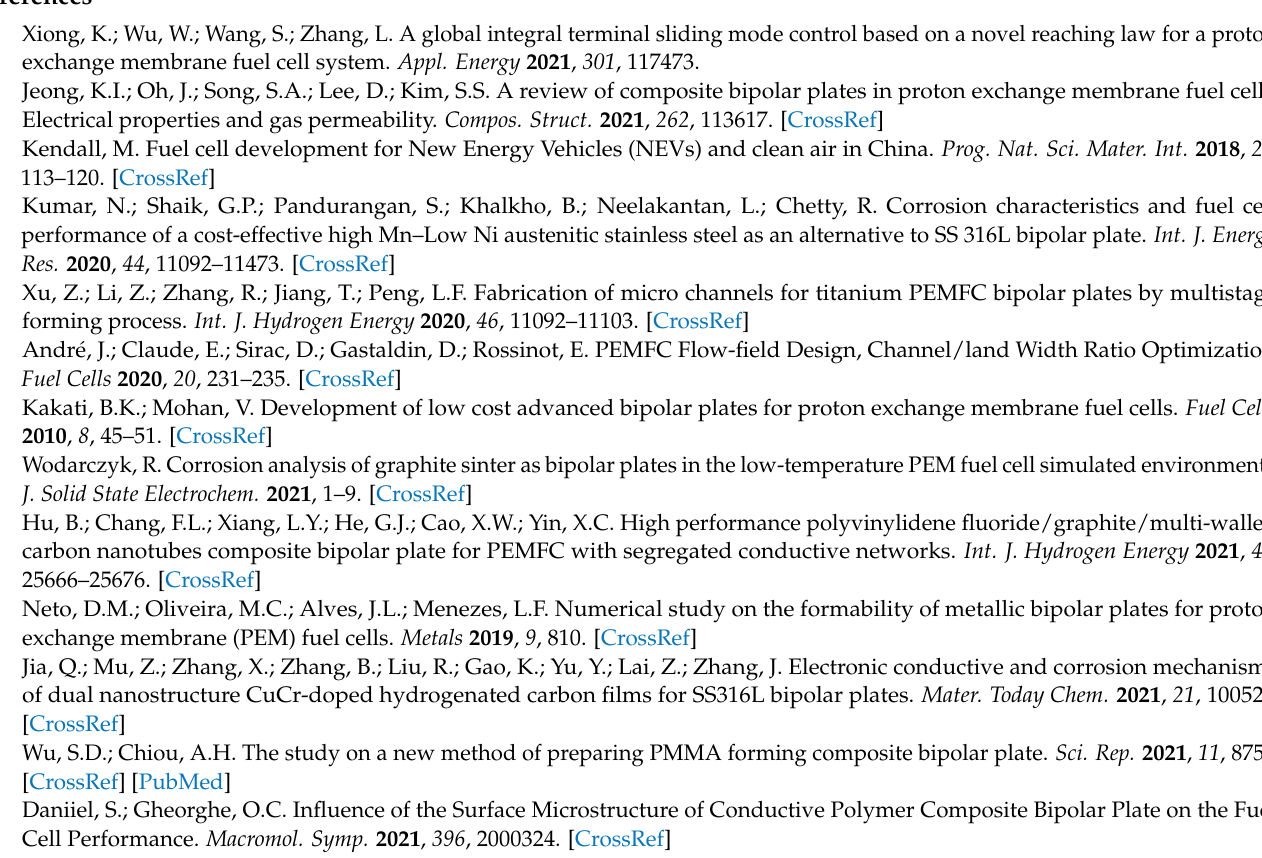
Figure S2. Distribution of catalyst on graphite matrix (TEM). Figure S3. TG of composite bipolar plates. Figure S4. Carbon nanofibers connect graphite particles. Figure S5. Nitrogen adsorption